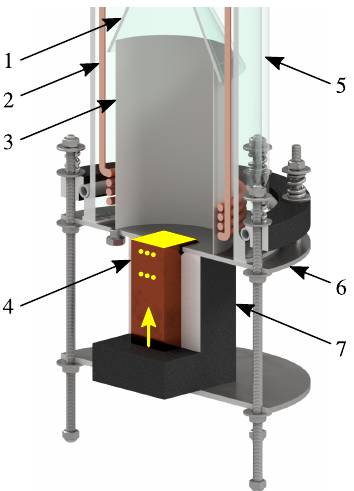
Figure 2. The experimental apparatus: (1) Funnel roof, (2) Auxiliary heater, (3) Separating tube, (4) Heated copper block, (5) Glass cylinder, (6) Bottom, (7) Thermal insulation. Yellow color marks the heating surface, six holes for TCs and orientation of cartridge heaters inside the